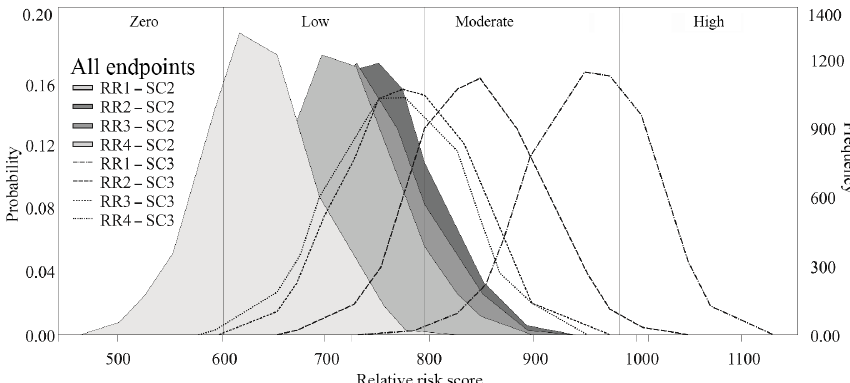
Figure 10. Probability profiles generated during a PROBFLO assessment, overlaid onto risk rank range (Zero, Low, Moderate and High) to describe the relative risk of the multiple sources and stressors, including altered flows, associated with alternative management scenarios considered in the Lesotho case study to all of the endpoints integrated in the